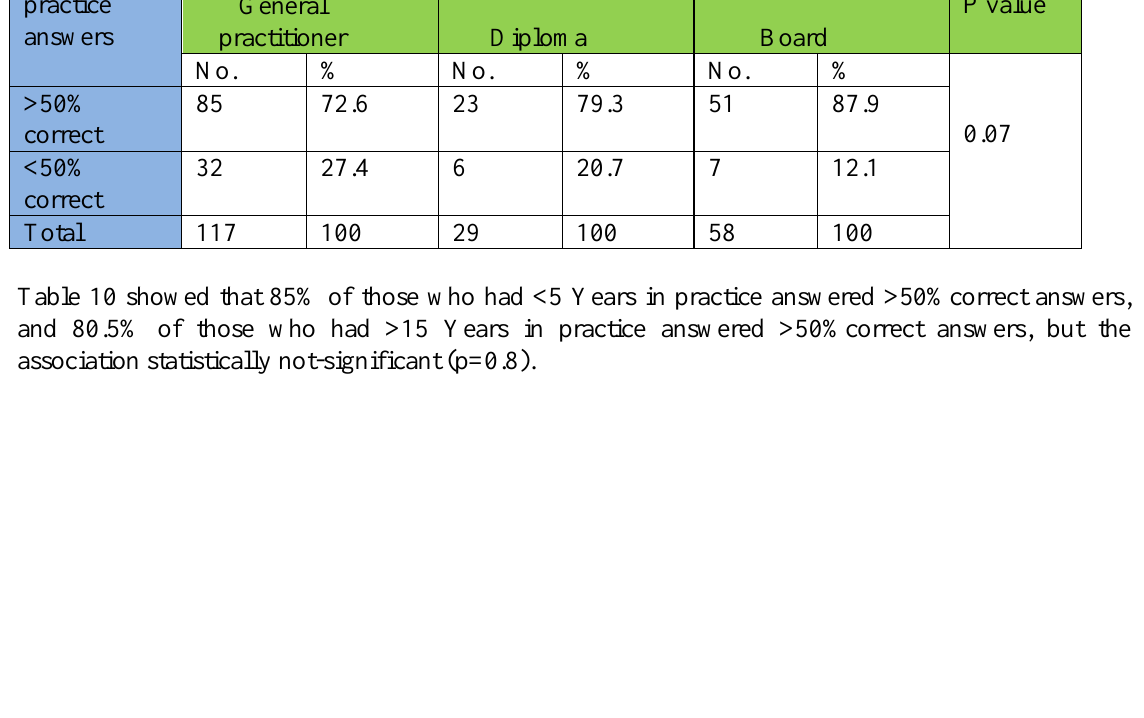
Table.9. relationships between practice category and qualification